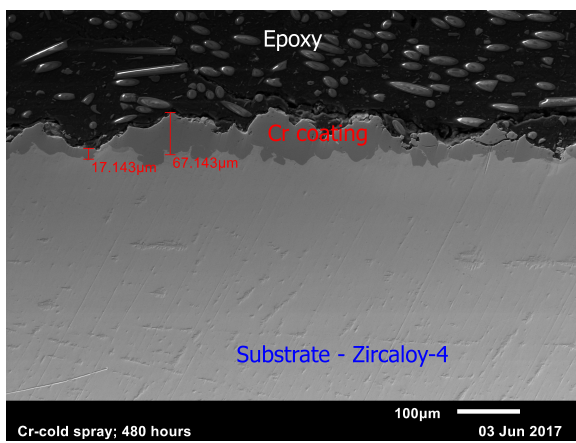
Figure 1. SEM micrograph of Cr cold-spray coated Zircaloy-4 cladding with nonuniform coating thickness. The top surface can be finished by polishing but the interface will remain nonhomogeneous due to high hardness of Cr